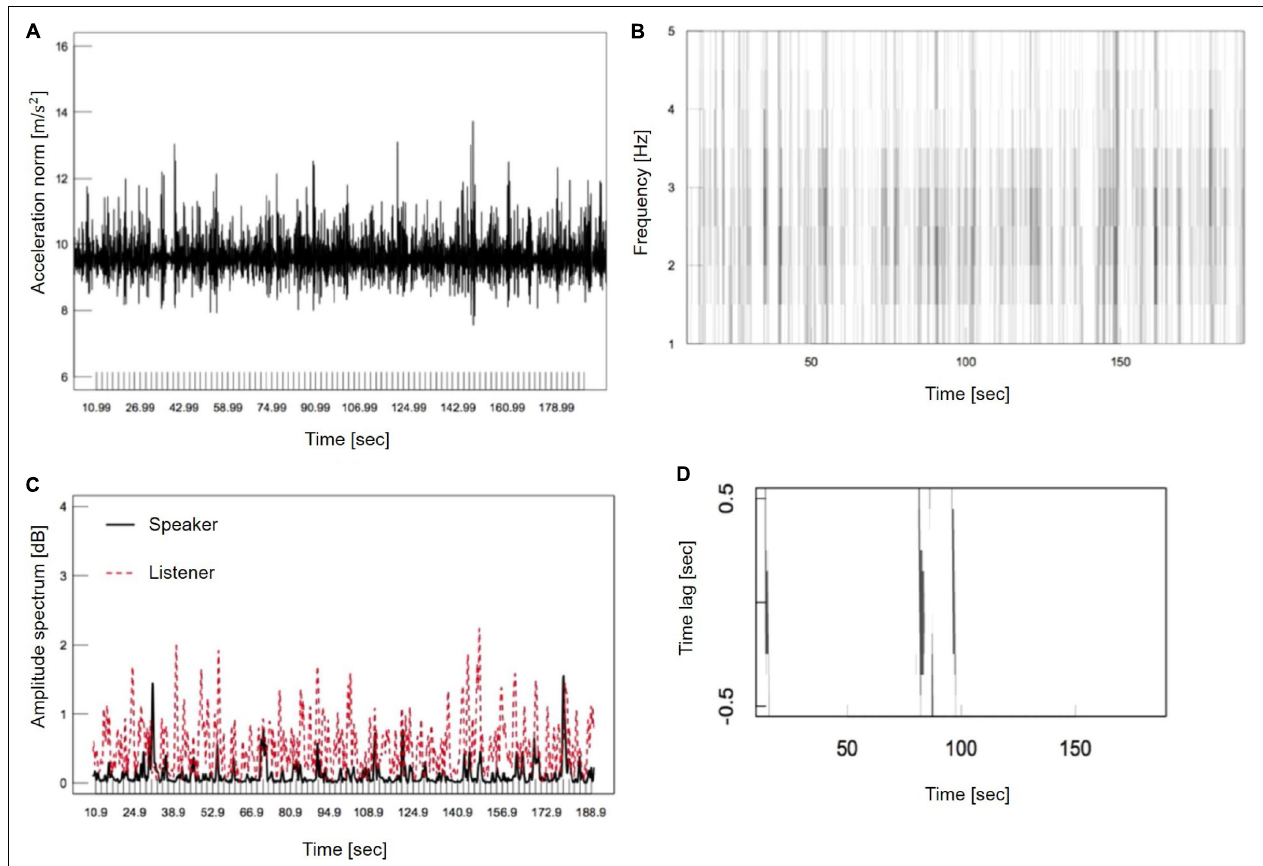
FIGURE 4 | Method of head motion synchronization detection. (A) Calculation of head motion acceleration norm. (B) Time-frequency analysis of the acceleration norm. (C) Amplitude spectrum of 3.0 Hz. (D) Identification of head motion